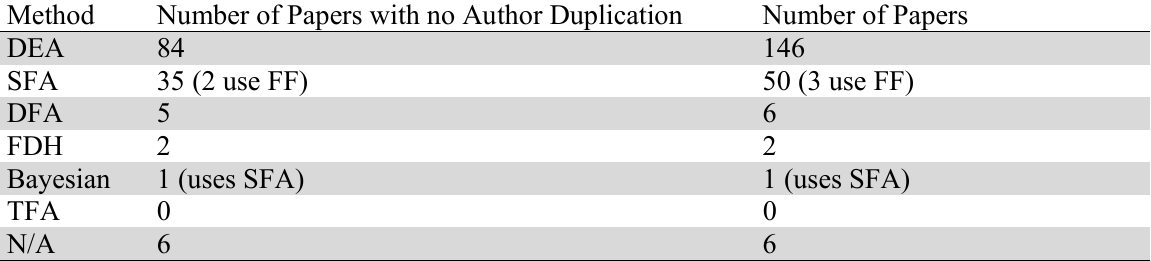
Counts of methods of determining